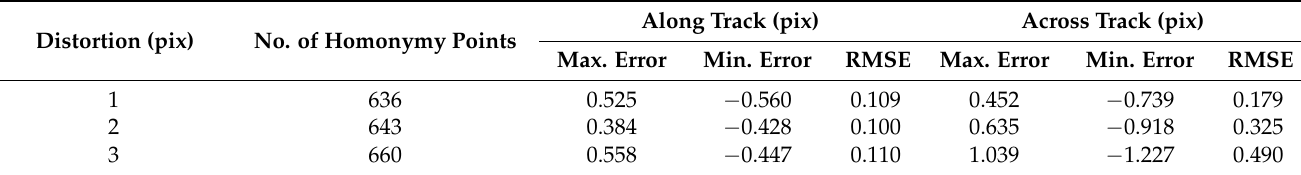
Table 7. Relative orientation residual of EA-stable-3 (left-middle image).